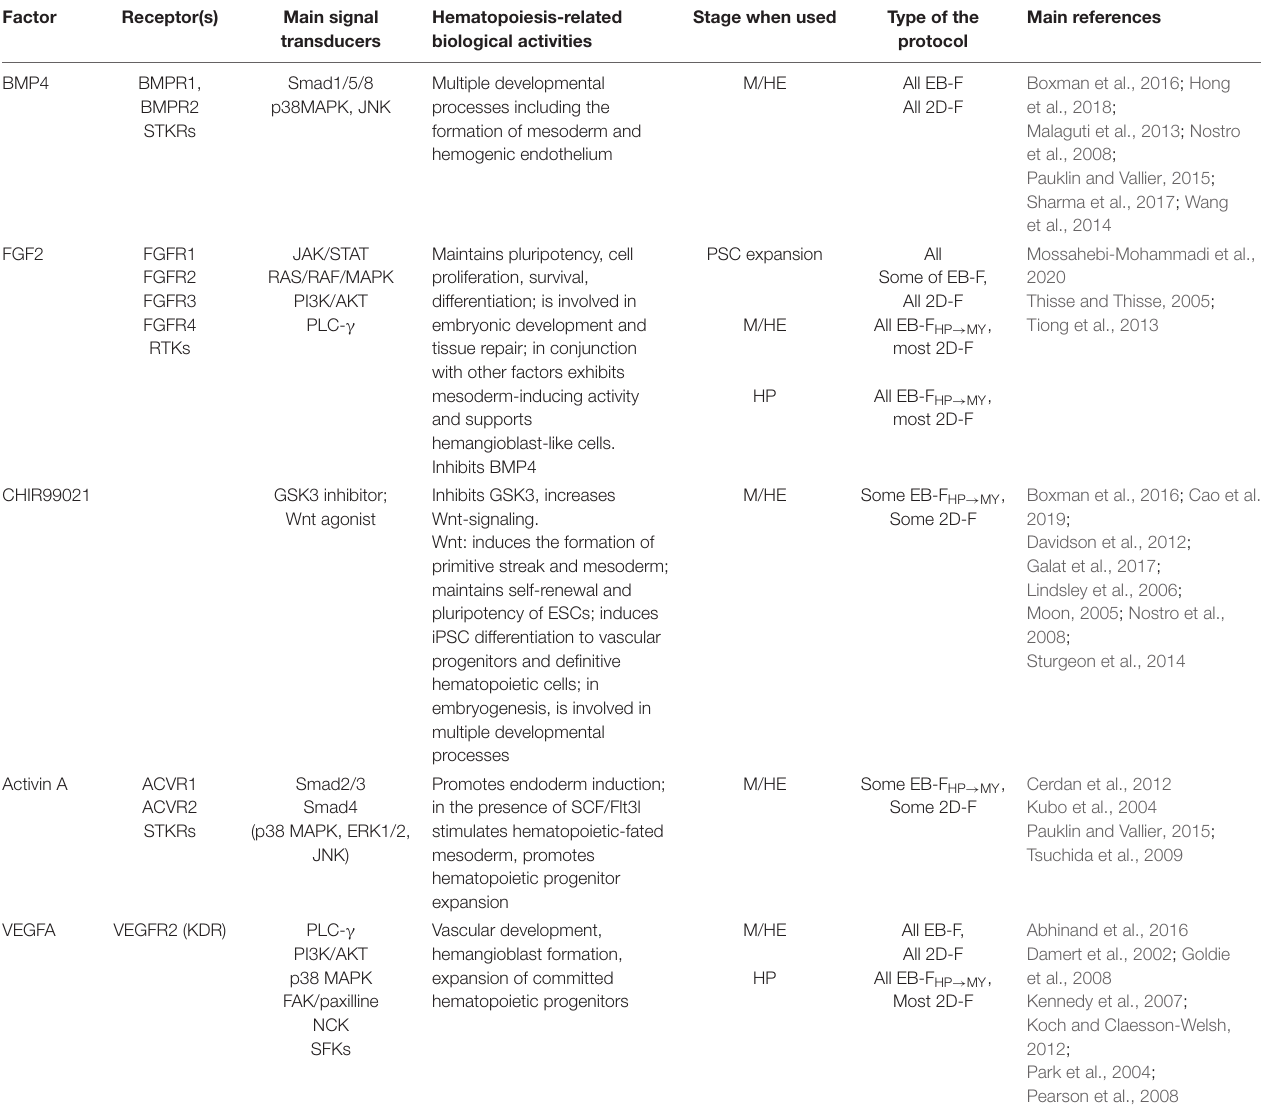
TABLE 3 | Exogenous factors and small molecules used during M/HE stage of iMPh differentiation.